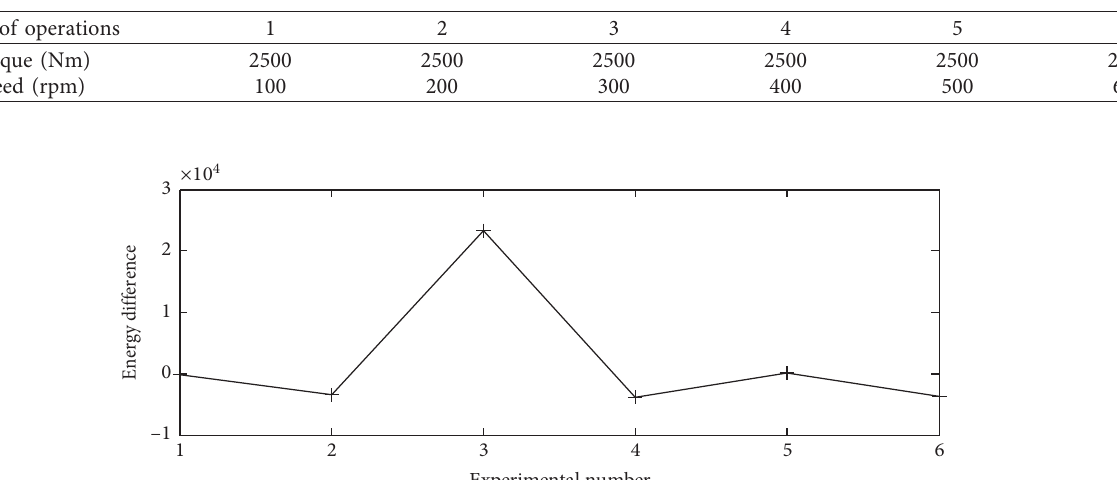
in different speeds. 1